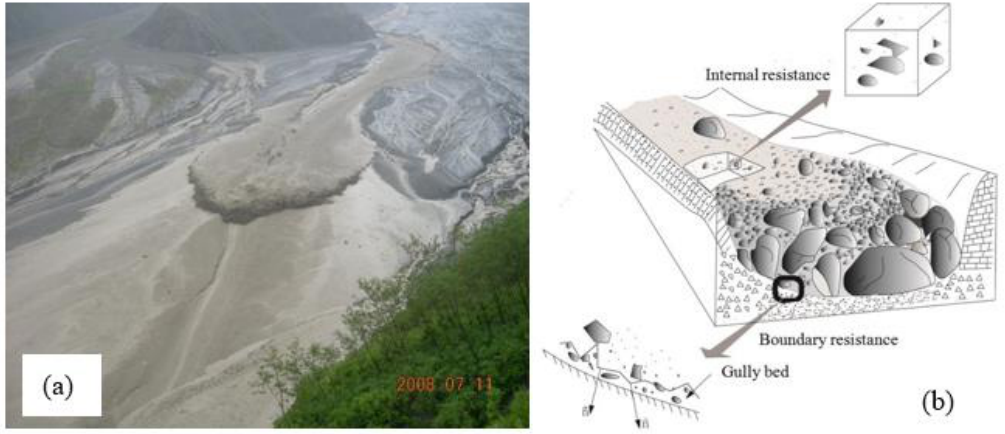
Figure 1. The photo and sketch of debris flow flowing in channel. ( a ) Debris flow in Jiangjia gully, Dongchuan, China [17]; ( b ) flow resistance in channel [18].